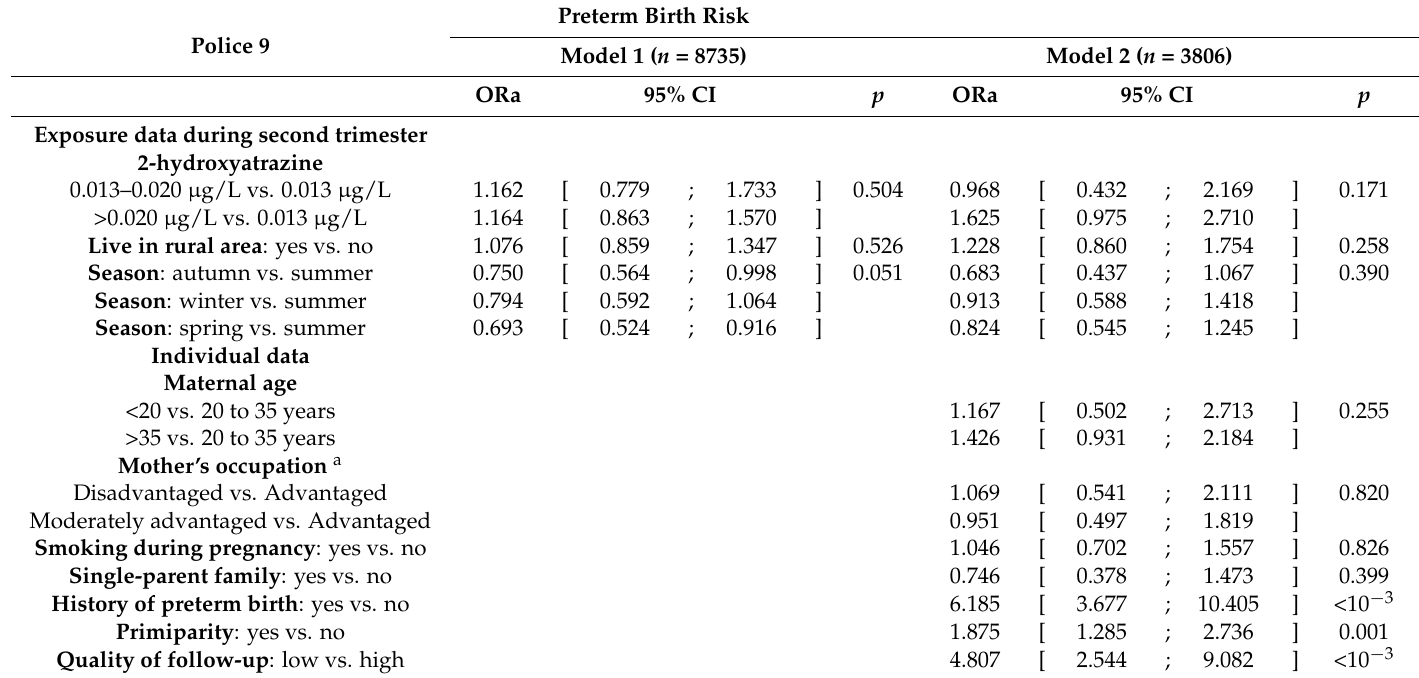
Table 4. Relation between exposure to 2-hydroxyatrazine in drinking-water during second trimester of pregnancy and prevalence of preterm birth babies. Multivariable analysis, Deux-Sèvres, France, 2007–2010 (2005–2006 excluded). Preterm Birth Risk Police 9 Model 1 ( n = 8735) ORa p Exposure data during second trimester 2-hydroxyatrazine